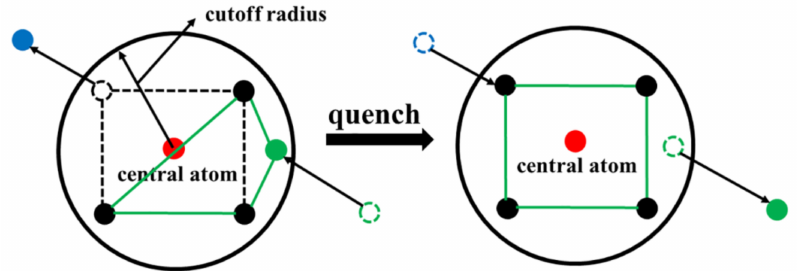
Figure 12. Two-dimensional illustration to clarify the ine ffi ciency of the CNA at high temperature and the strategy to overcome this